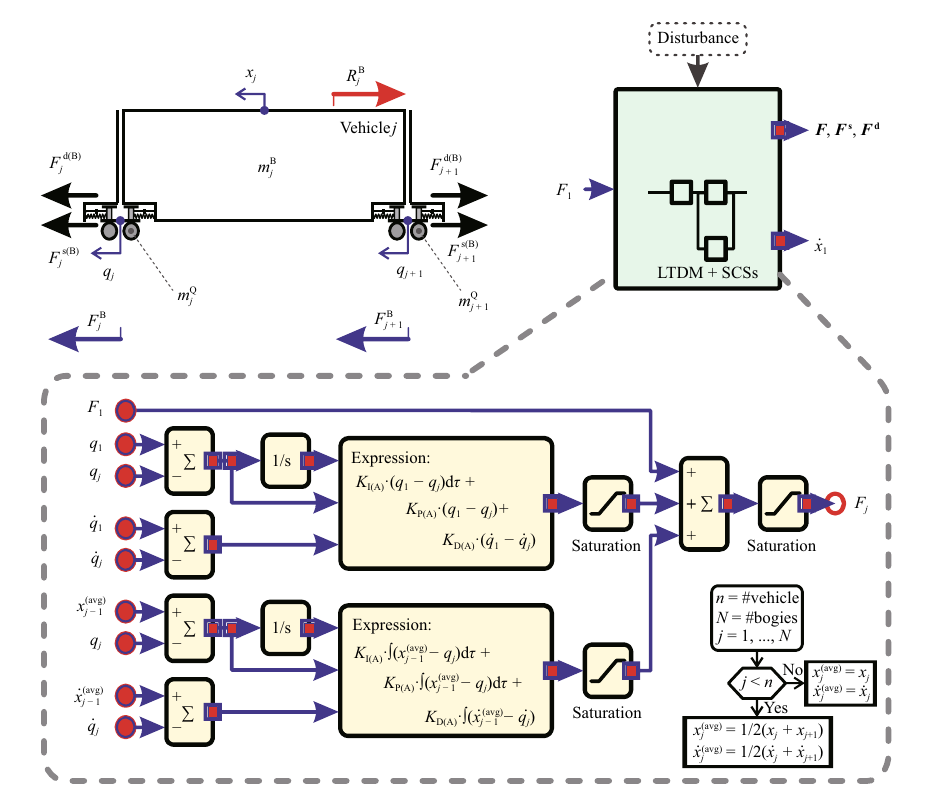
Fig. 17 Essential part of the block diagram of the slave control systems enabling the realization of the active vibration damping in the MUT with Jacobs’ bogies (all MUT bogies are